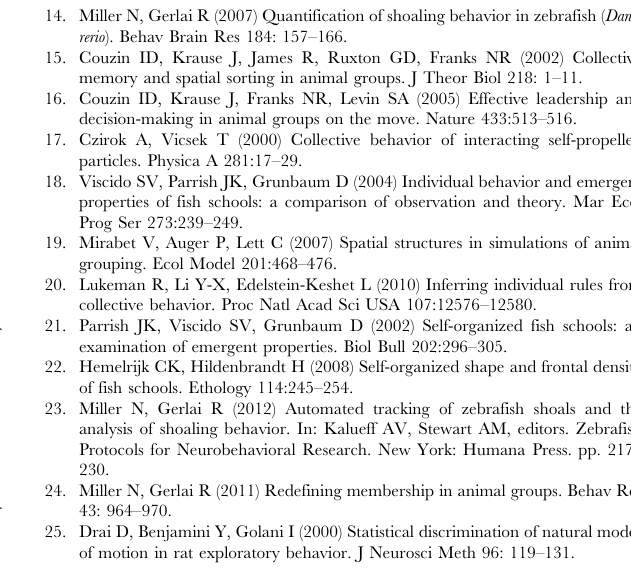
Table S1 Comparisons of polarization distributions by day in Experiment 1. Summed distributions (shown in Figure 1) were compared between repeated exposures to the testing environment using a 2-sample Kolmogorov-Smirnov test. The top half of the table presents the test statistic values; the bottom half presents p-values. Non-significant p-values are shaded. Table S2 Comparisons of polarization distributions by hour in Experiment 2. Summed distributions (shown in Figure 2) were compared between hours of the session using a 2-sample Kolmogorov-Smirnov test. The top half of the table presents the test statistic values; the bottom half presents p-values. Non-significant p-values are shaded. (PDF) Table S3 Schooling and shoaling segment lengths by day in Experiment 1. Mean durations of schooling and shoaling segments for each day of Experiment 1. Mean segment lengths 6 standard deviations are given in seconds. (PDF) Table S4 Comparisons of polarization distributions by group size in Experiment 3. Summed distributions (shown in Figure 5) were compared using a 2-sample Kolmogorov-Smirnov test. The top half of the table presents the test statistic values; the bottom half presents p-values. (PDF) Video S1 Sample video from Day 1 of Experiment 1. (AVI) Video S2 Sample video from Day 2 of Experiment 1, of the same individuals as Video